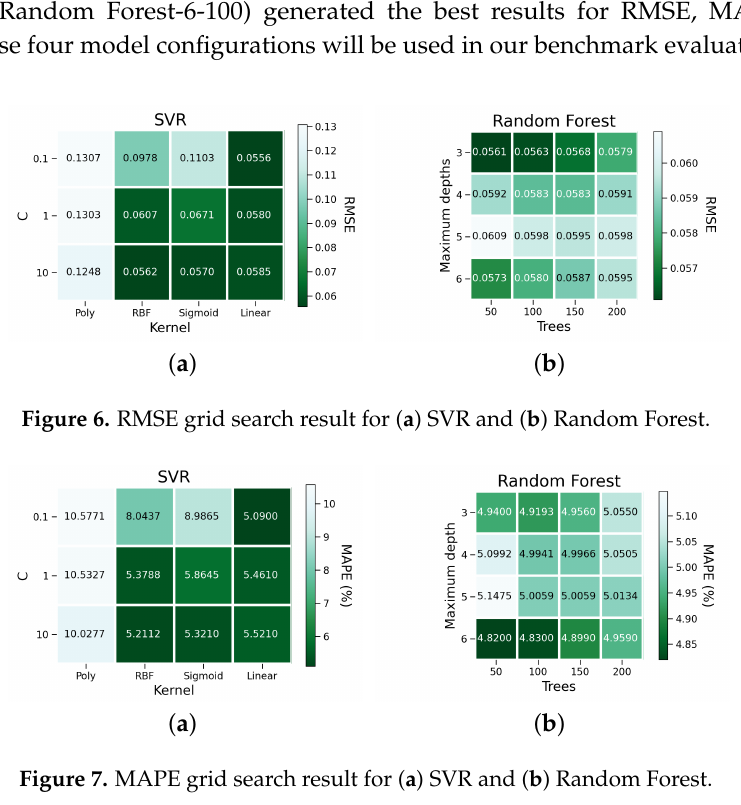
Figure 7. MAPE grid search result for ( a ) SVR and ( b ) Random Forest.